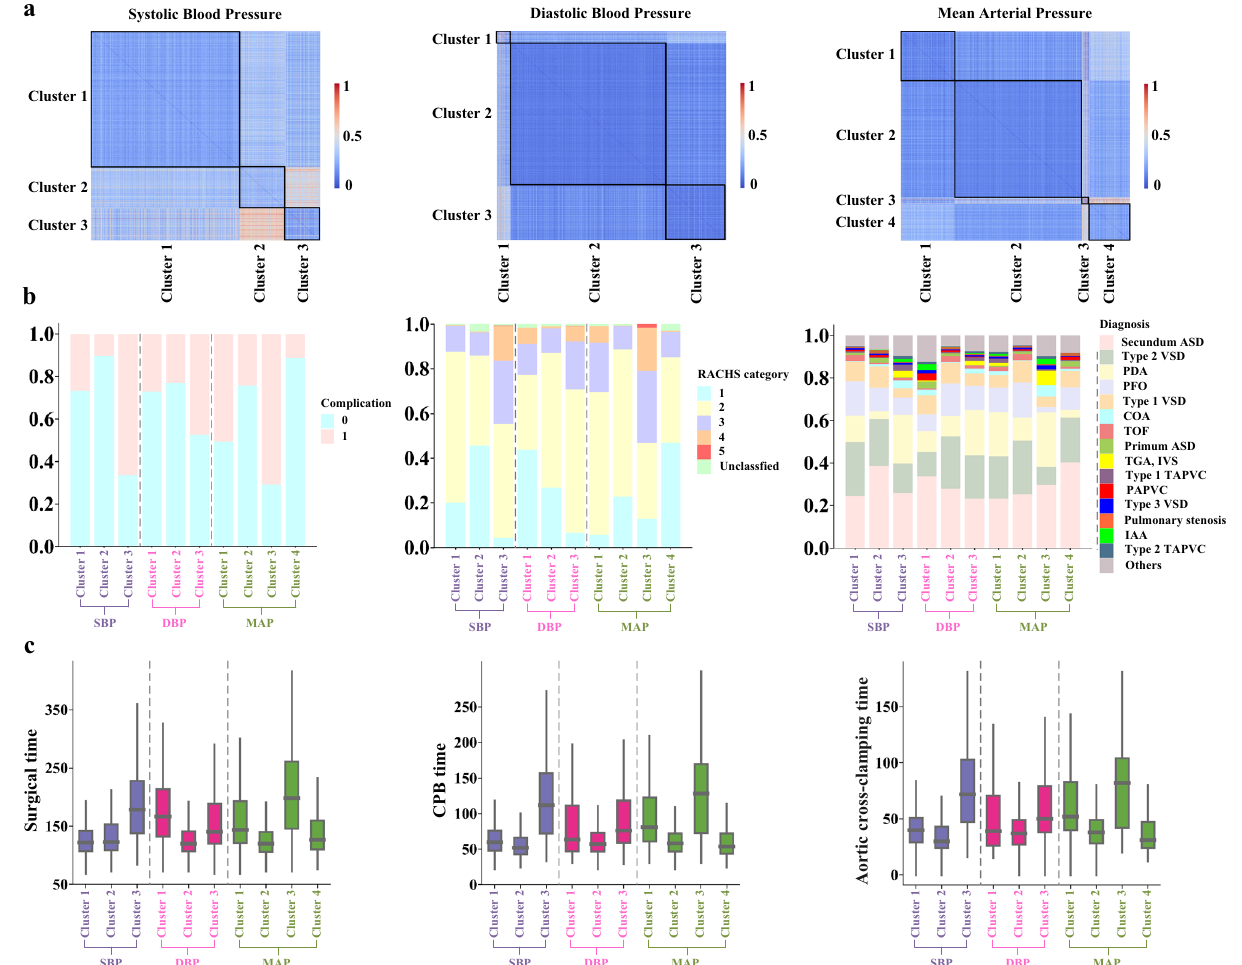
Figure 2. Clustering of intraoperative blood pressure and comparison of other characteristics between clusters. (a) Similarity matrix of blood pressure where rows and columns were ordered by a partition detected through k-means clustering. (b) Composition of each cluster in terms of whether the patients experienced postoperative complications, risk categories of operation, or primary diagnoses. (c) Distribution of surgical time, CPB time, or aortic cross-clamping time between each cluster. In the box plots, box edges represent the 25th and 75th percentiles, the centerline shows the median and whiskers extend from the box edges to the 1.5× interquartile range and *means P < 0.001 (Kruskal–Wallis